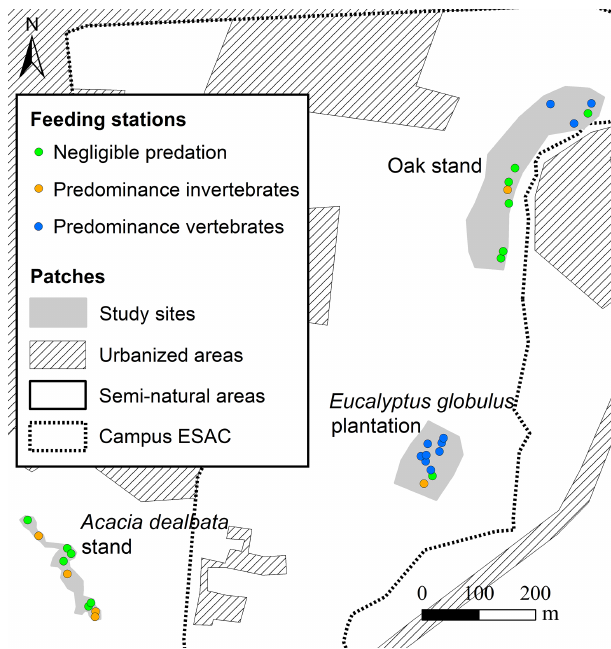
Figure 3. Location of the feeding stations according to shared pat- terns regarding the predominant seed predators and the level of seed predation.